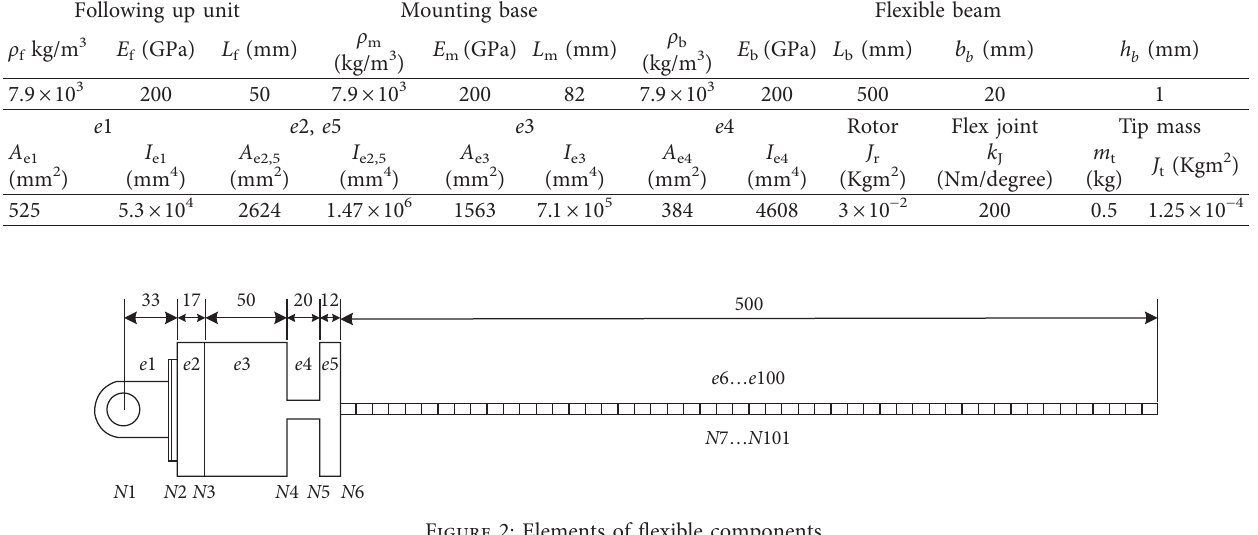
Table 1: Parameters of the manipulator and special elements.